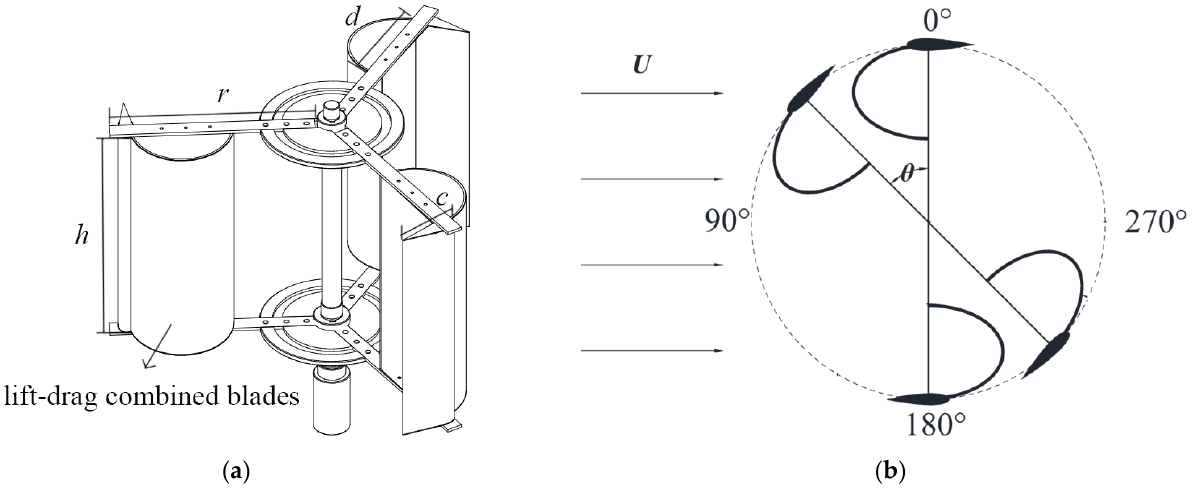
Figure 4. Model parameters and rotation azimuth of the LDCS: ( a ) structural parameter; ( b ) rotation azimuth. Table 1. Structural parameters of LDCS model with three blade numbers.